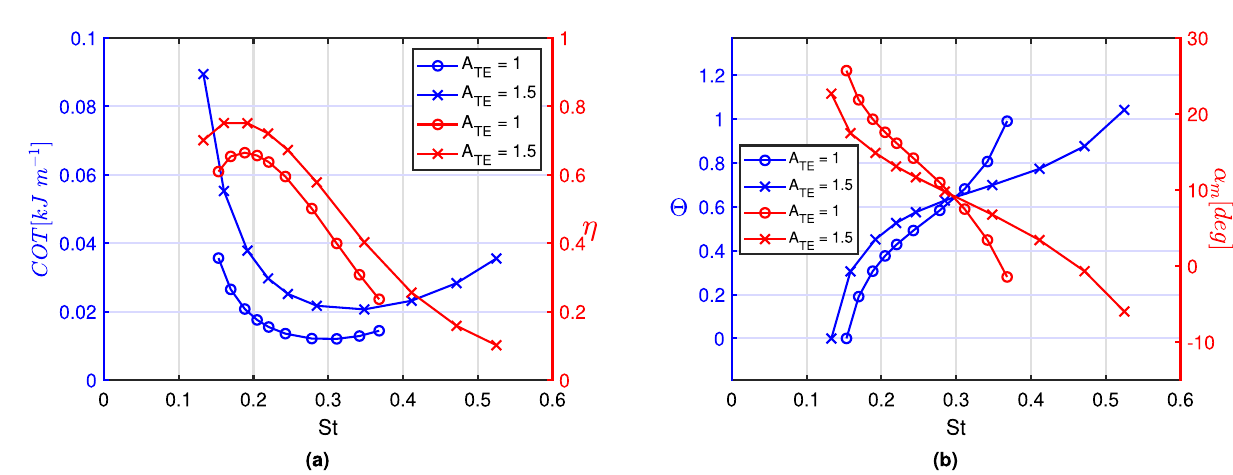
Figure 4. ( a ) Cost of transport of the whole body (blue) and efficiency of the propulsor (red) as function of the Strouhal number St . ( b ) Feathering parameter (cid:31) (blue) and maximum angle of attack 𝛼 m (red) for the inviscid case as function of the Strouhal number. Comparison between A TE = 1 and 1.5 for the inviscid